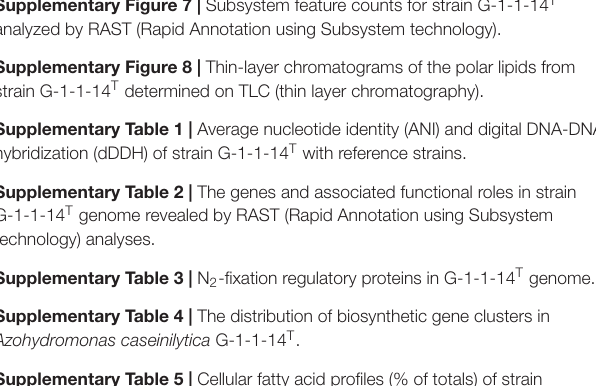
Supplementary Figure 7 | Subsystem feature counts for strain G-1-1-14 T analyzed by RAST (Rapid Annotation using Subsystem technology). Supplementary Figure 8 | Thin-layer chromatograms of the polar lipids from strain G-1-1-14 T determined on TLC (thin layer chromatography). Supplementary Table 1 | Average nucleotide identity (ANI) and digital DNA-DNA hybridization (dDDH) of strain G-1-1-14 T with reference strains. Supplementary Table 2 | The genes and associated functional roles in strain G-1-1-14 T genome revealed by RAST (Rapid Annotation using Subsystem technology)